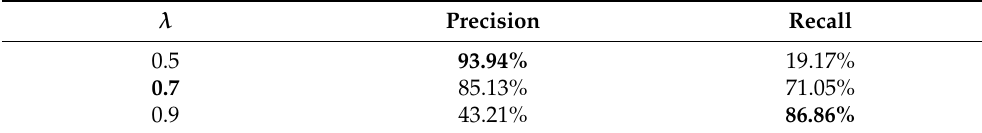
Table 12. Anomaly Detection λ Selection.